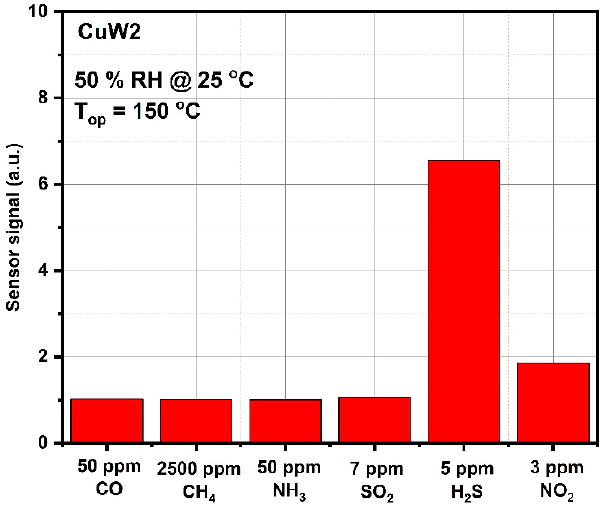
Figure 12. Selective sensitivity aspects for CuW2 towards different gas interfering .